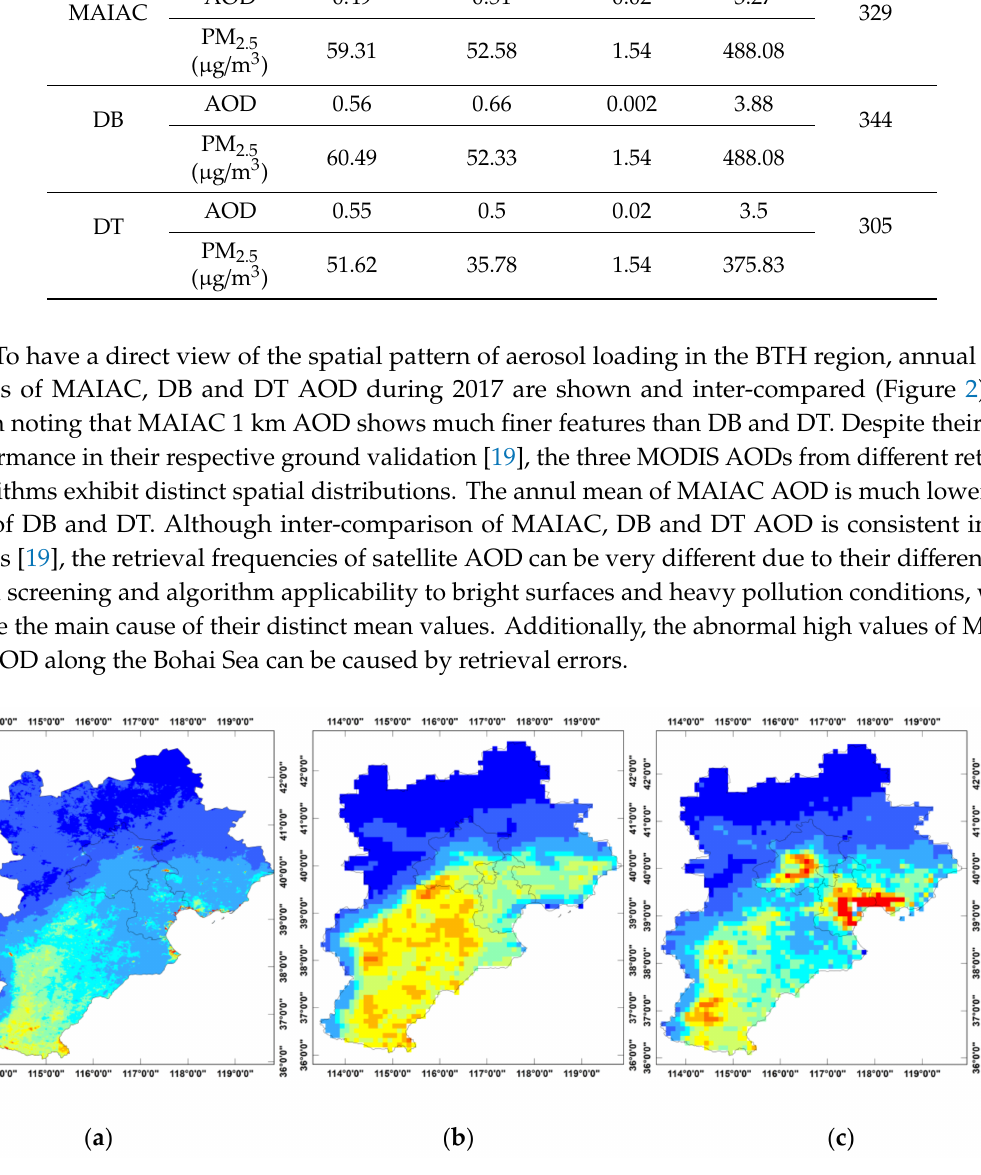
Figure 2. Annul mean of MAIAC ( a ), DB ( b ) and DT ( c ) AOD data in BTH during